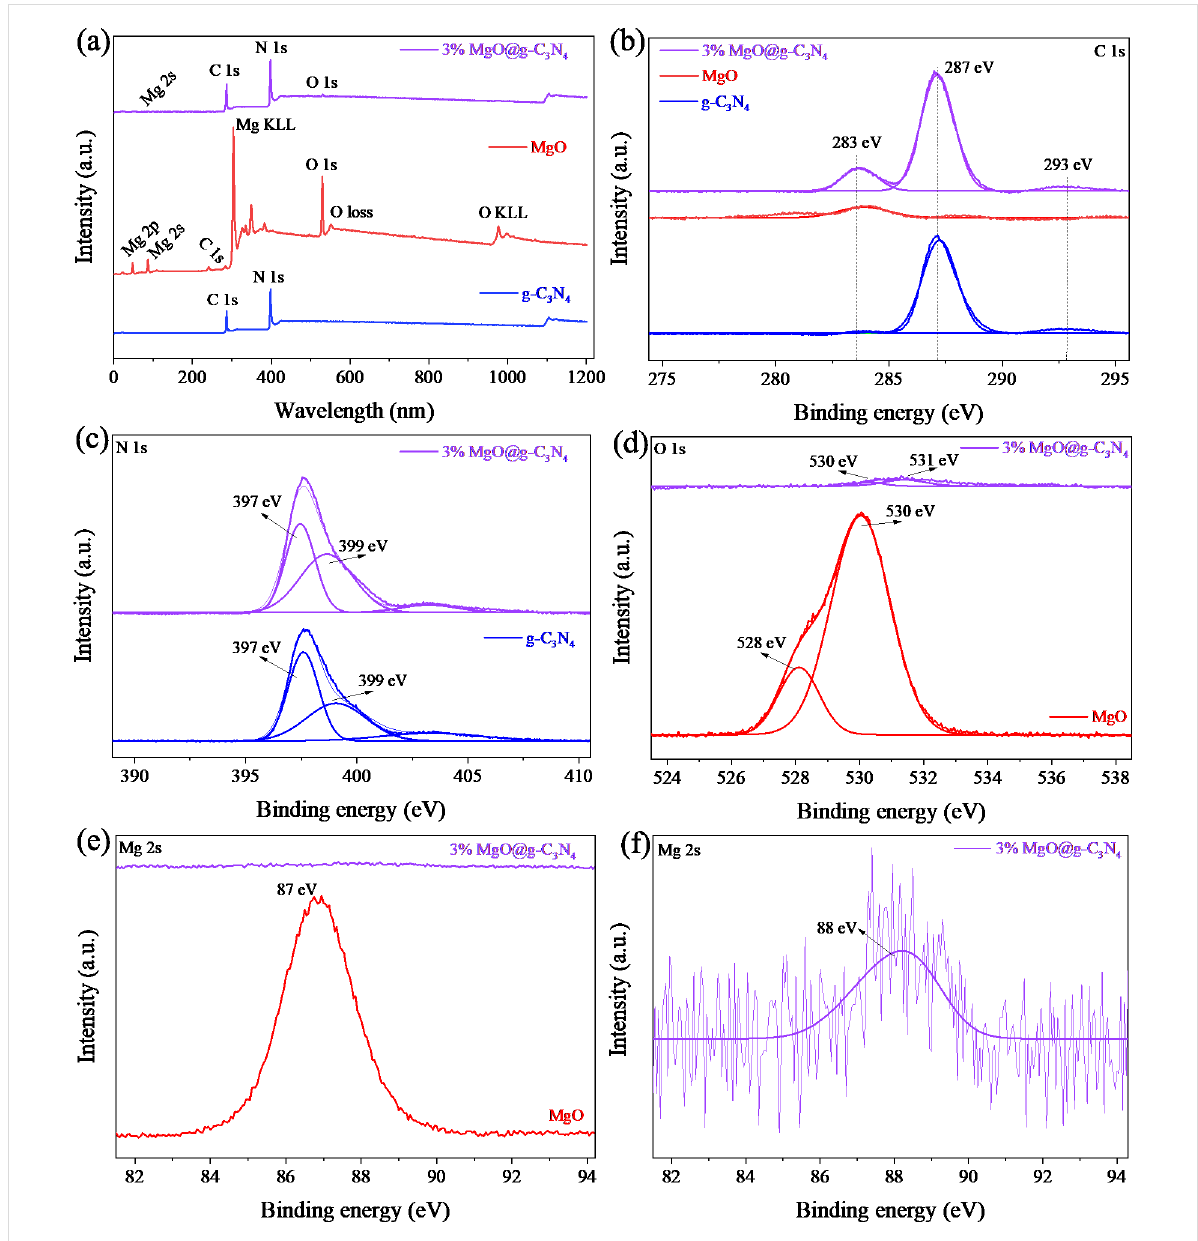
Figure 8: The XPS survey (a), HR − XPS C1s (b), N 1s (c), O 1s (d), C 1s (c), and Mg 2s (e, f) of the materials.